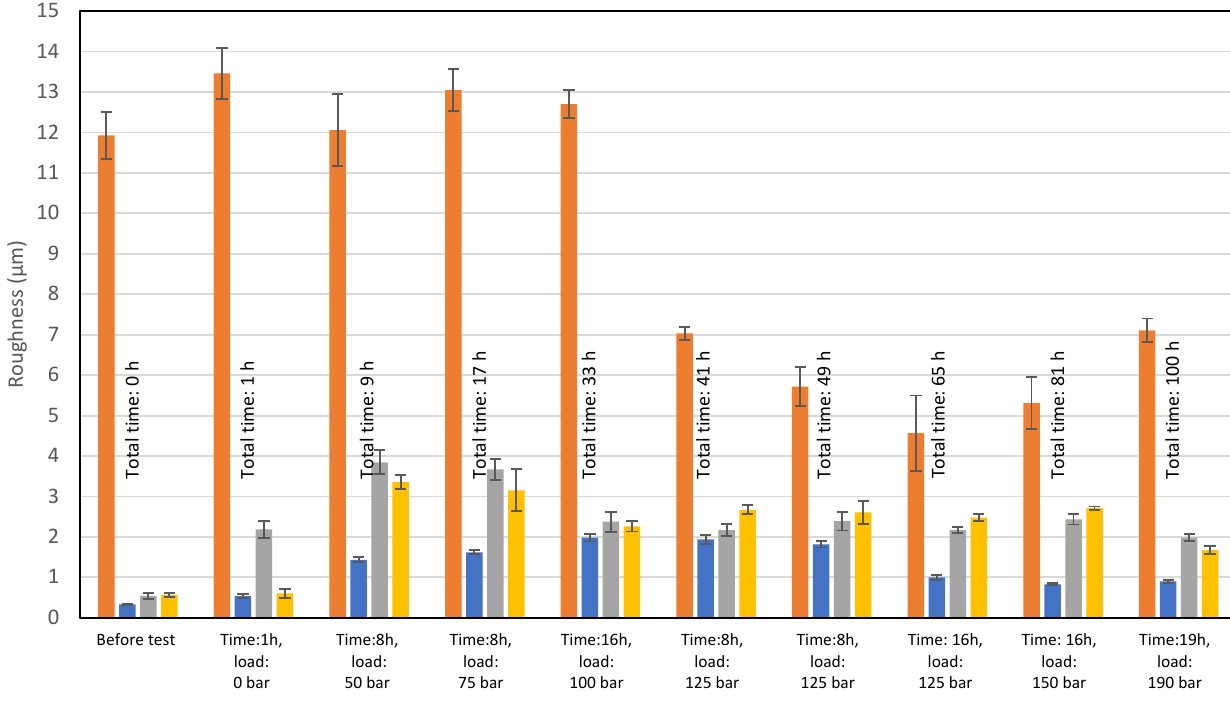
Figure 8. Roughness measurement results of all tested parts.